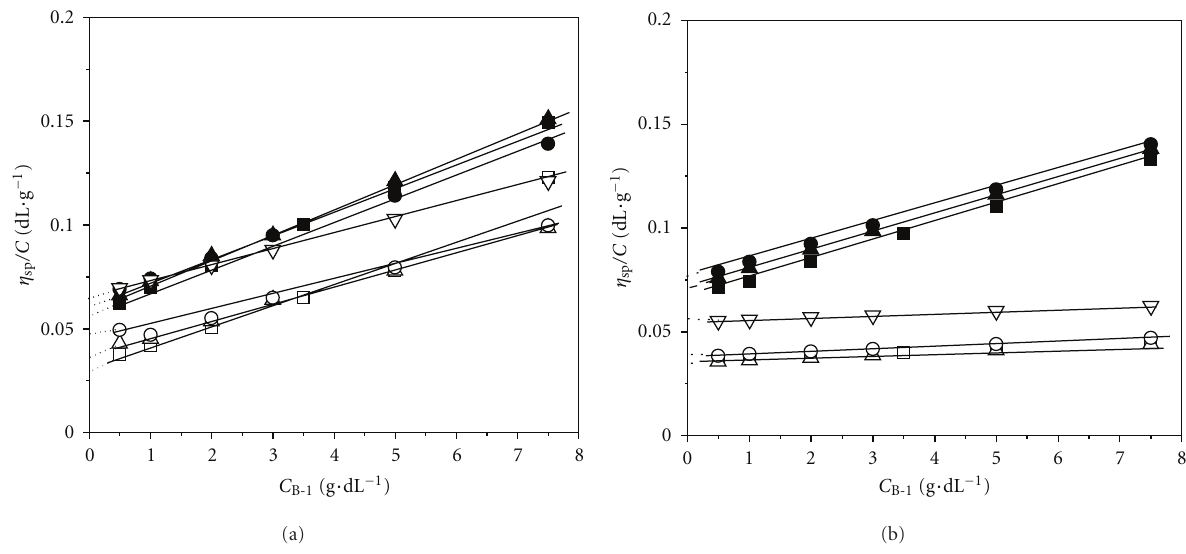
Figure 3: Reduced viscosity for B-1 + surfactant mixtures in aqueous solutions at di ff erent temperatures (in ◦ C) (a) SDS ( (cid:3) ) 0% 30 ◦ C, ( (cid:4) ) 0% 50 ◦ C, ( (cid:2) ) 0.001 30 ◦ C, ( (cid:5) ) 0.001 50 ◦ C, ( (cid:4) ) 0.05% 30 ◦ C, ( • ) 0.05% 52 ◦ C, and ( ∇ ) 1% 30 ◦ C and Reduced viscosity for B-2 + surfactant mixtures in aqueous solutions at di ff erent temperatures (b) ( (cid:3) ) 0% 30 ◦ C, ( (cid:4) ) 0% 70 ◦ C, ( (cid:2) ) 0.0005% 30 ◦ C, ( (cid:5) ) 0.0005% 68 ◦ C, ( (cid:4) ) 0.05% 30 ◦ C, ( • ) 0.05% 71 ◦ C, and ( ∇ ) 1% 30 ◦ C. Line represents fitted